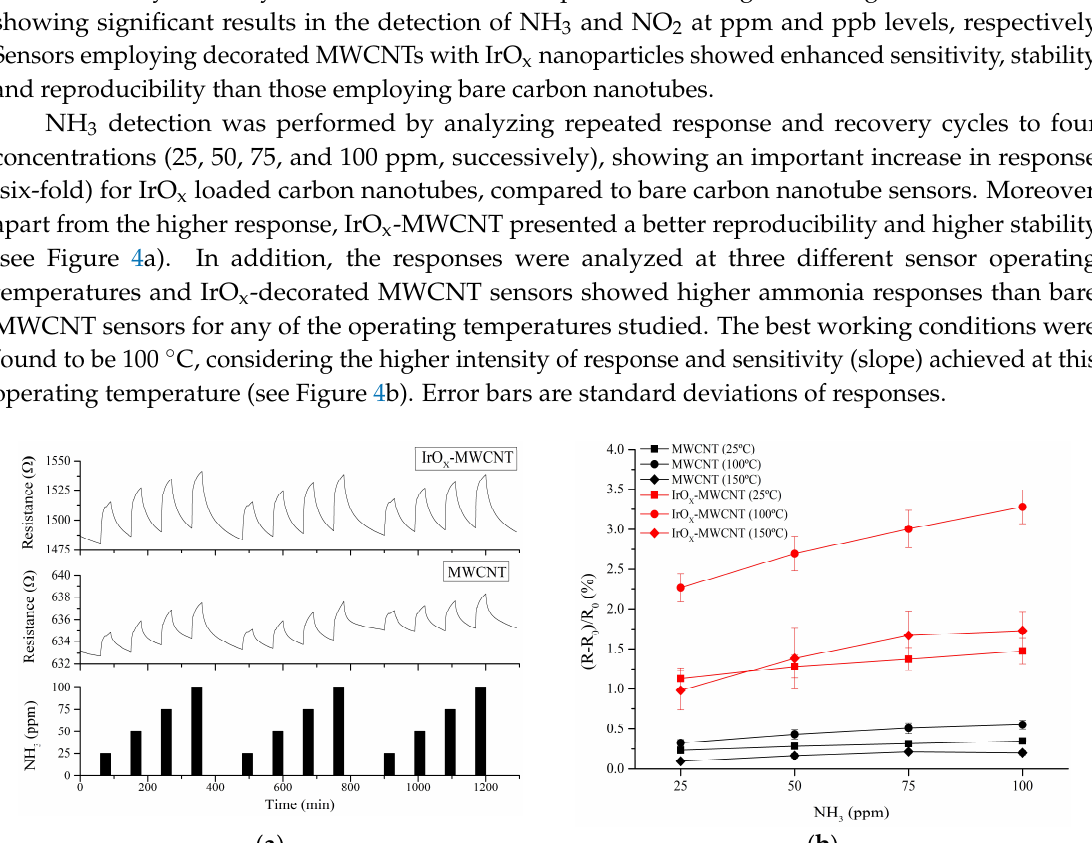
Figure 5. Typical response and recovery of the resistance signals when the sensors are exposed to different concentrations of NO 2 ( a ). Calibration curves obtained for NO 2 for bare carbon nanotubes and IrO X -MWCNTs at different operating temperatures under dry conditions. Error bars are standard deviations of responses ( b ).